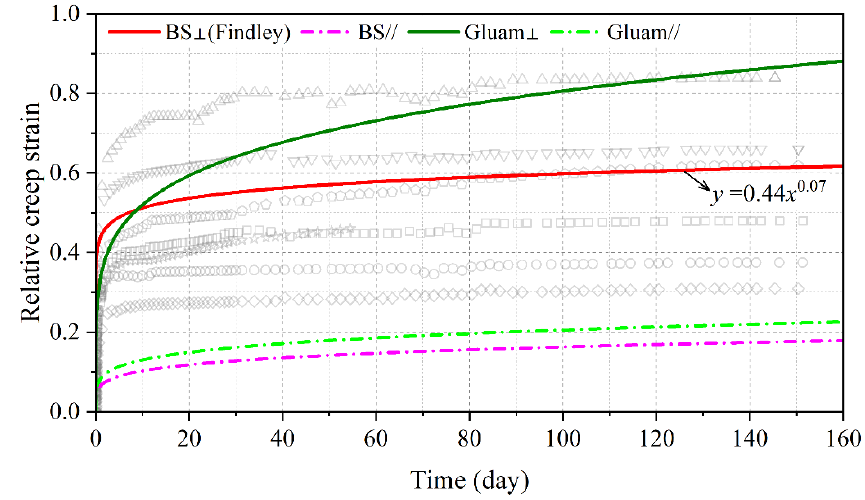
Figure 8. Relative creep strain of BS perpendicular to grain.